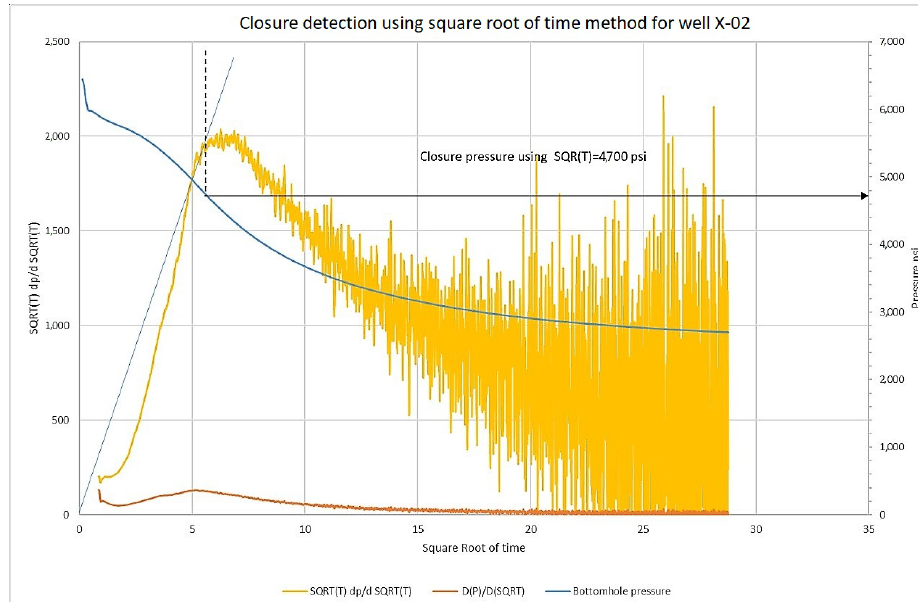
Figure 29. Closure identification using the square root of time technique for well X-02.